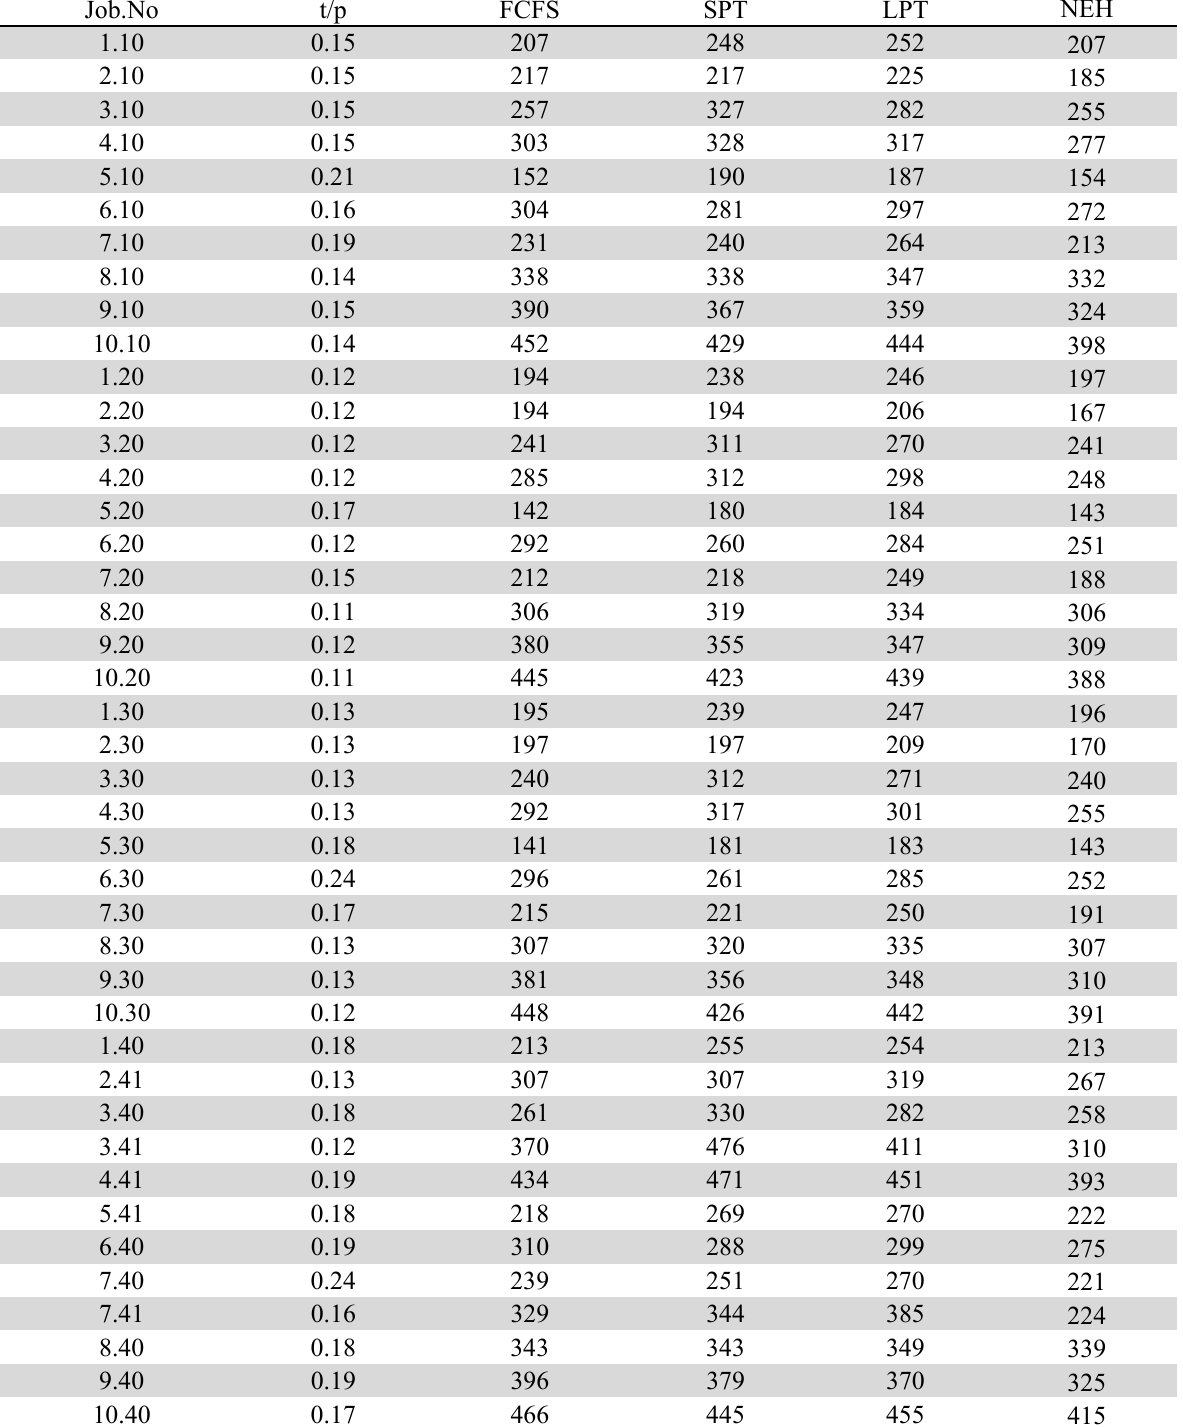
Performance assessment for t/p<0.25